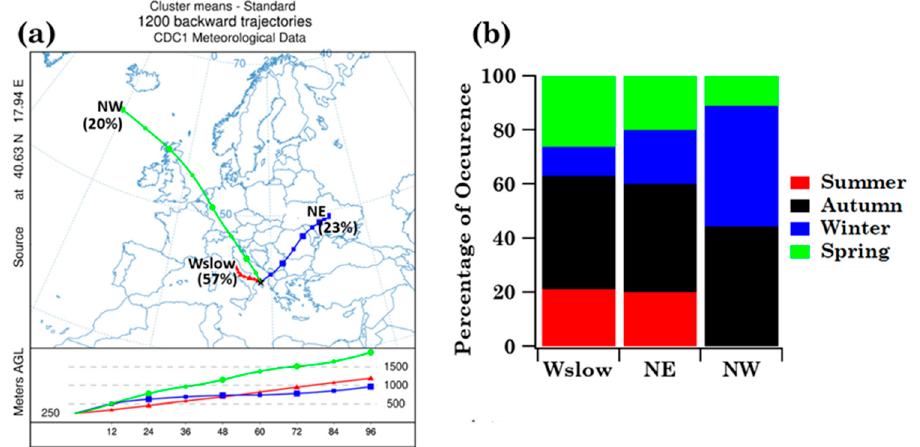
Figure 6. ( a ) Centroids associated with the main airflow types calculated by the cluster analysis of the four-day analytical back-trajectories that reached Brindisi at 250 m AGL throughout the sampling period and ( b ) the corresponding airflow frequency of occurrence in summer, autumn, winter, and spring in Brindisi. Table 3. Mean values ± the standard error of the mean (SEM) and minimum (Min) and maximum (Max) values of number of families, pollen grains, Others and Unclassified pollen grains, and Shannon and Simpson indices at the family level for the three main advection patterns identified in Brindisi. n ◦ Cluster